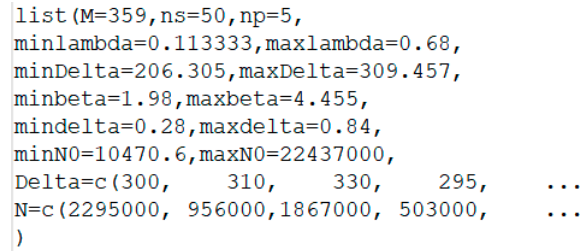
Figure 5. Example of definition of the initial values of the variables and the experimental fatigue data for a hypothetic fatigue case